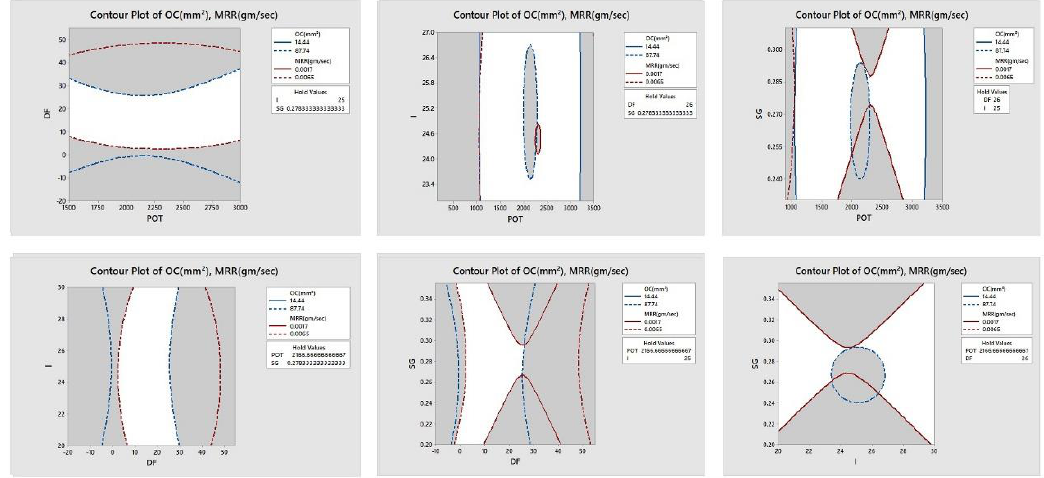
Fig. 11. Control plots of responses